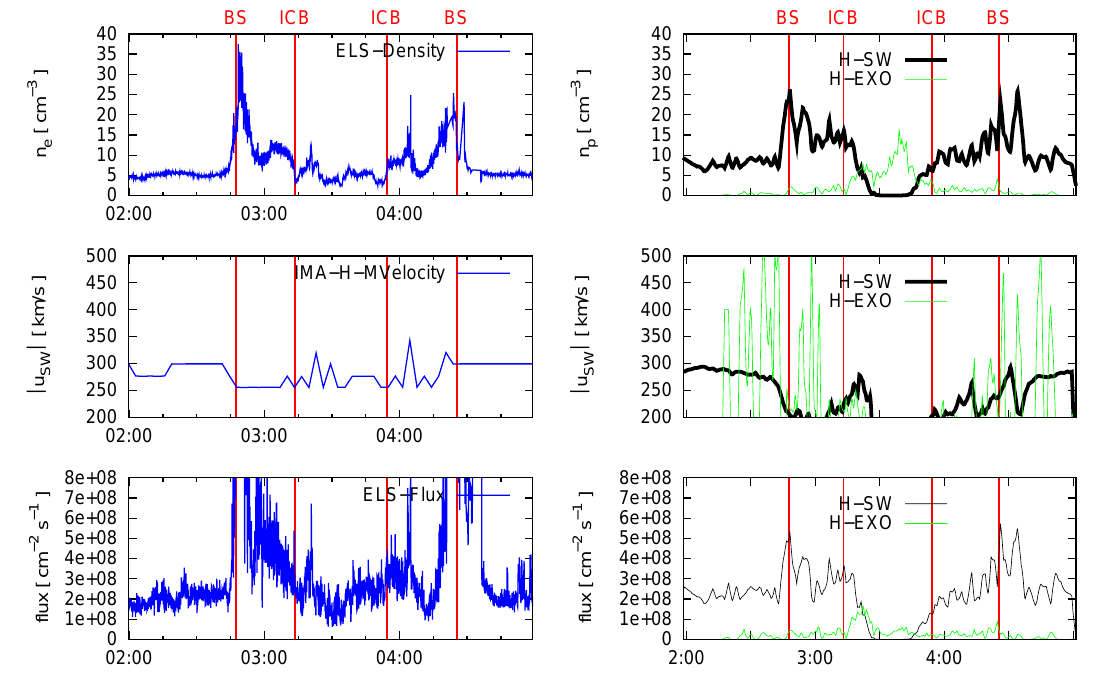
Fig. 8. Comparison of MEX/ASPERA-3 data (left) with simulation results along the MEX trajectory (right). From top to bottom: Solar wind density, proton velocity and solar wind flux. Quantities of exospheric hydrogen are presented in